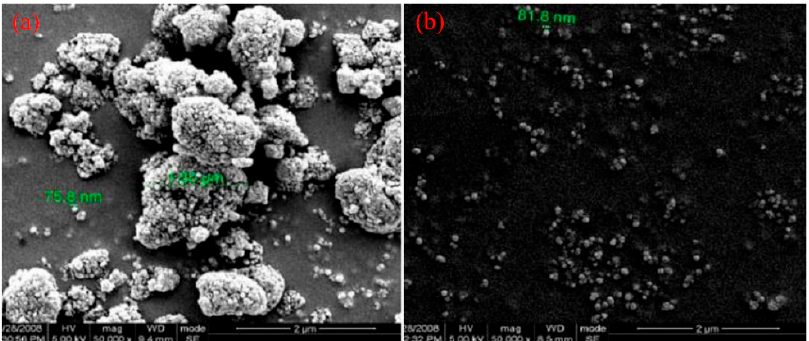
Figure 2. Scanning electron microscopy (SEM) images of TiO 2 nanoparticles where ( a ) untreated TiO 2 and ( b ) lactic acid-treated TiO 2 (g-TiO 2 ) [19].